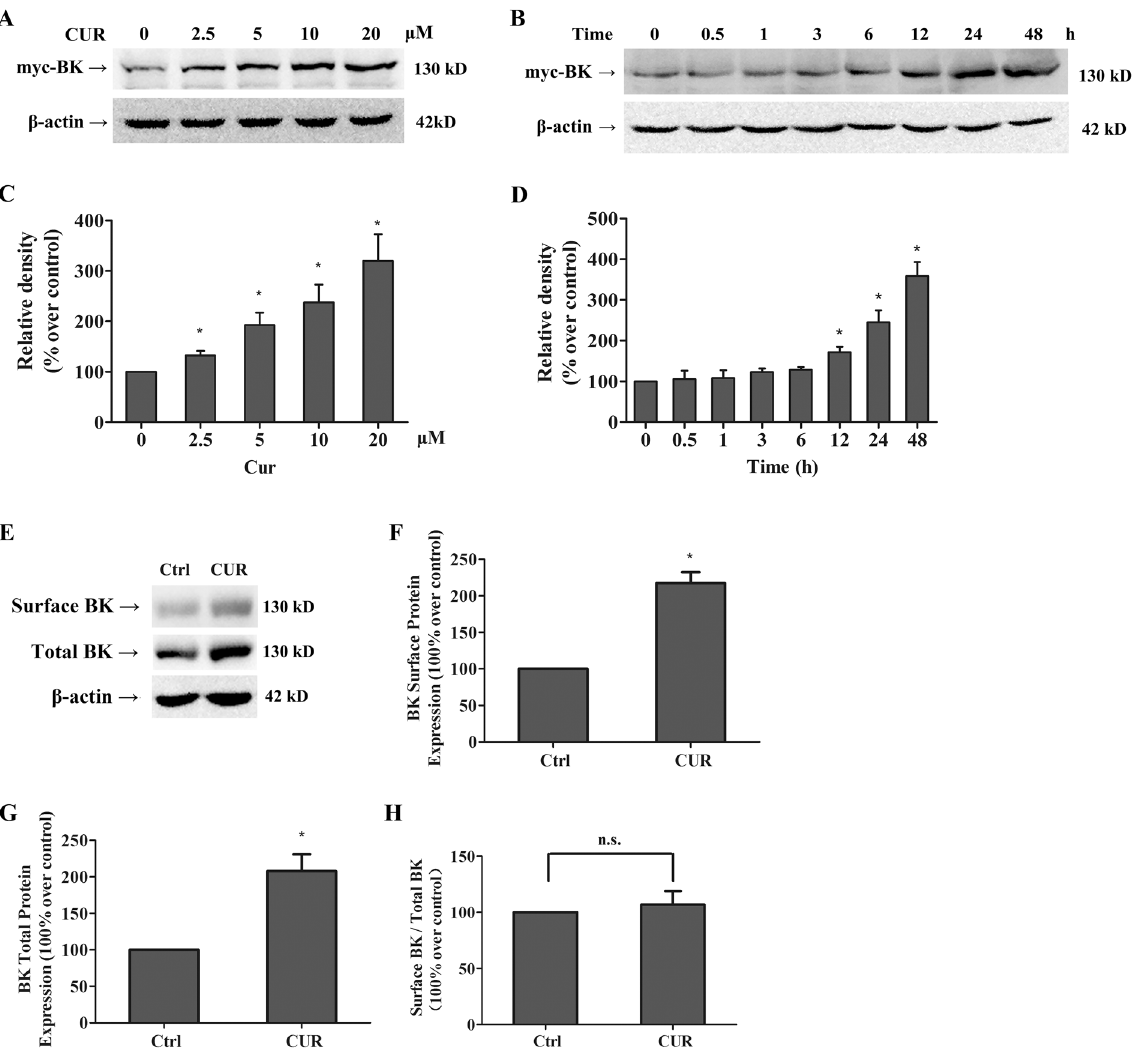
Fig 4. Curcumin increased the surface and total BK protein expressions in HEK293 cells. (A) Dose-dependent and time-dependent effects of curcumin on the BK protein in transfected HEK293 cells. Western blot analysis indicated that treatment with 2.5 to 20 μ M curcumin for 24 h increased BK protein level in a concentration-dependent manner (n = 5). (B) The BK protein expression in HEK293 cells incubated with 10 μ M curcumin for the time course of 0.5h to 48 h, showing an increase of BK protein level in response to curcumin (n = 3). Graphic representative of densitometric data of the total BK protein level shown in (C) and (D). (E) Representative western blot of total and surface BK protein expressions by cell surface biotinylation. The densitometric data showing the surface (F) and total (G) BK protein level and ratio of surface over total BK protein level (H) (n = 3). * p < 0.05; n.s., not